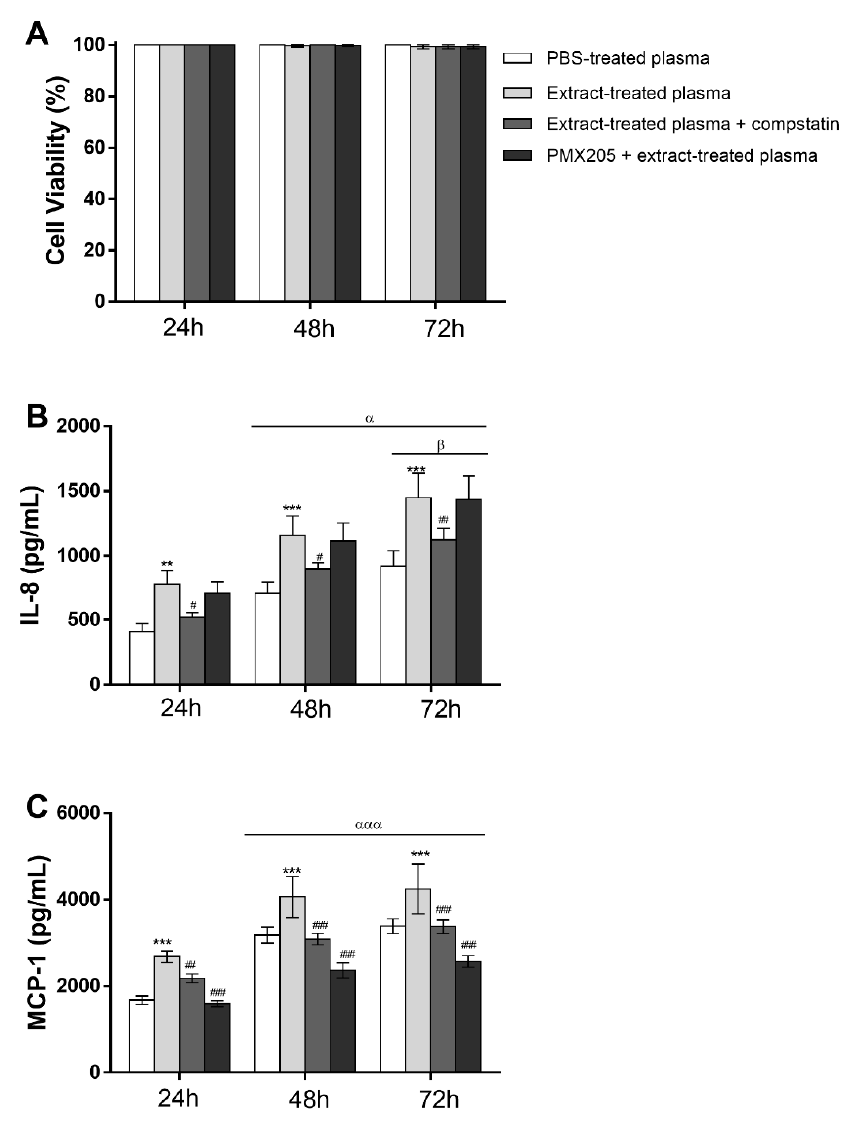
Figure 9. Cell viability and chemokine levels in cultures of EA.hy926 cells stimulated with Pararama hair extract-treated plasma. The endothelial cell line EA.hy926 (5 × 10 4 cells/well) was treated with plasma (1:10 in culture medium) collected from blood samples stimulated with PBS (PBS-treated plasma), Pararama hair extract (extract-treated plasma) and Pararama hair extract in the presence of compstatin (extract-treated plasma and compstatin). After stimulation, the production of IL-8 and MCP-1 was determined in the culture supernatants by flow cytometry. To evaluate the role of C5a, Pararama hair extract-treated plasma in the presence of PMX205 was used in cultures (PMX205+ extract-treated plasma). The results are presented as the mean ± SD of three independent experiments. ** p < 0.01 compared